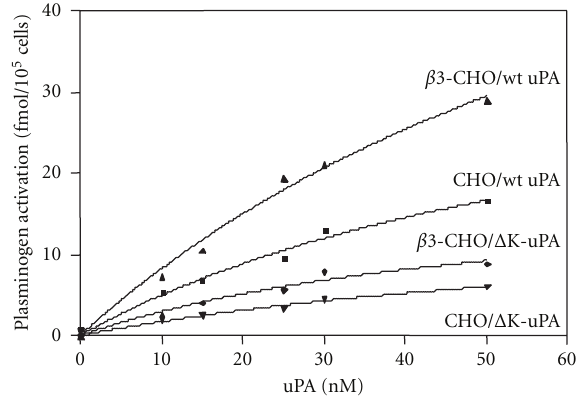
Figure 4: Integrin-dependent plasminogen activation on the cell surface. Parental CHO cells and β 3-CHO cells in wells of 96-well plates were treated with PIPLC to deplete uPAR, and incubated with wt or delta kringle ( Δ K ) uPA in the cold binding bu ff er for 1h at 4 ◦ C. The cells were washed with the binding bu ff er, and plasminogen activation was determined using Glu-plasminogen and SpectrozymePL chromogenic substrate at 37 ◦ C. We found that β 3-CHO cells showed much higher ability to activate plasminogen in a manner dependent on the uPA added. Deletion of the kringle domain (with Δ K -uPA) markedly reduced the plasminogen activation on β 3-CHO, indicating that α v β 3 and uPA-dependent plasminogen activation required the kringle domain of uPA. These results suggest that the binding of uPA kringle to integrin α v β 3 induces plasminogen activation